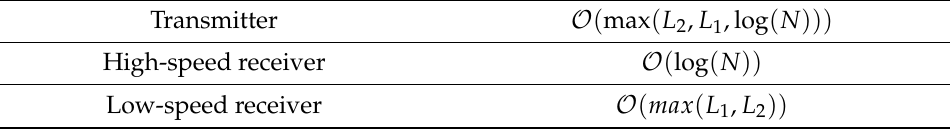
Table 3. Complexity analysis